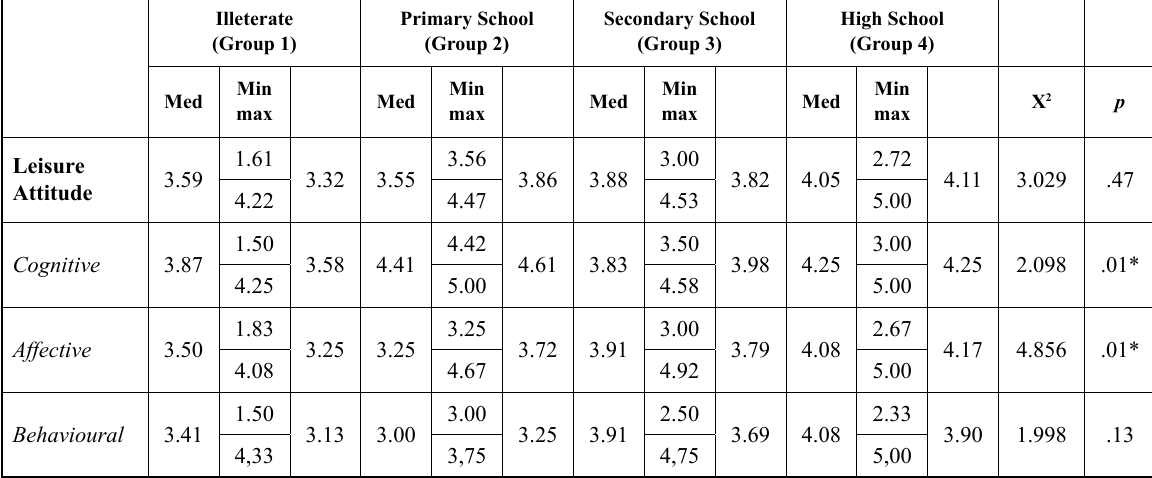
Table 8. Leisure attitude levels of the ındividuals living in western cities by the variable of educational